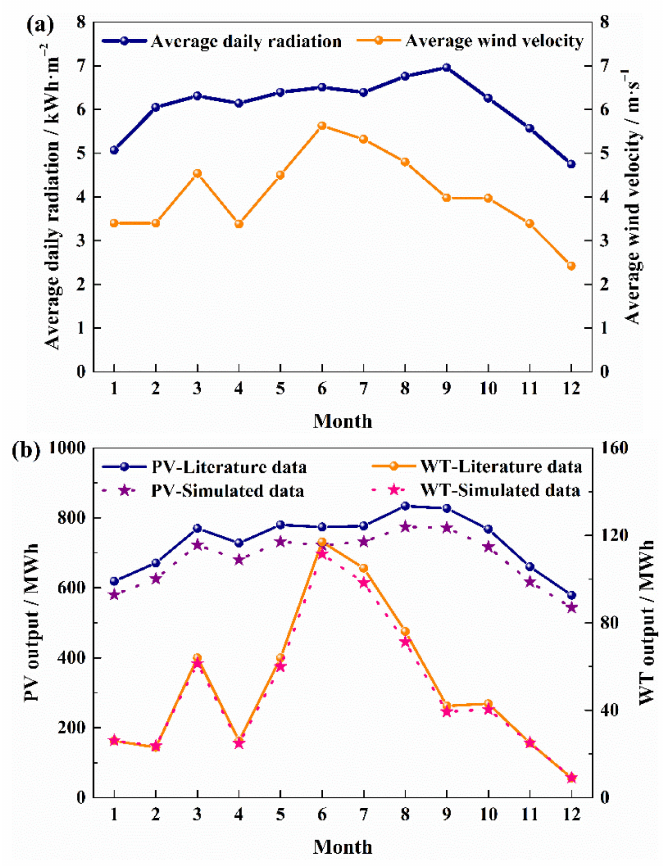
Figure 6. Model verification: ( a ) meteorological data; ( b ) result